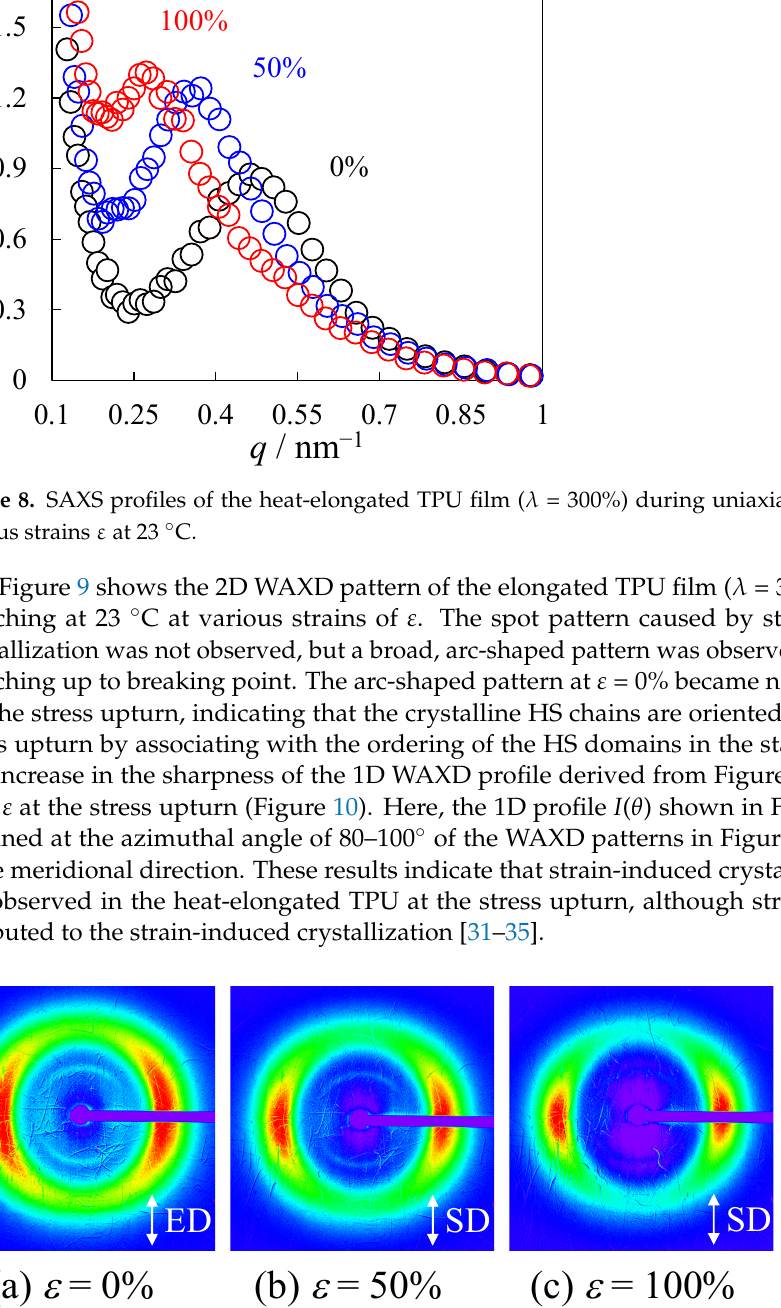
Figure 10. One-dimensional WAXD profiles of the heat-elongated TPU film ( λ = 300%) during uni- axial stretching at 23 °C at various strains ε. Thus, the stress increase at the stress upturn with λ in the elongated TPU film, as shown in Figure 1, is not attributed to the fibrillation and strain-induced crystallization, but is attributed to the increase in the densification of the HS domains tied in the stacked domain structure by the taut tie chain of the SS domains, which prevents the HS domains from fracturing during stretching due to the large energy storage that occurs during stretching to prevent the large deformation of the HS domains. This concept differs from familiar concepts regarding the strengthening at the stress upturn, which requires fibril- lation, and the strain-induced crystallization of the HS domains, but is consistent with the strengthening mechanism suggested in the heat-elongated HDPE film consisting of a stacked structure, in which the fracture of crystalline lamellae is suppressed during stretching [48]. 4. Conclusions We found that strengthening occurred without sacrificing the strain recovery by the heat elongation of the TPU film consisting of a high HS content. The stress continuously increased with elongation ratio λ , i.e., the stress at break increased from 55 to 136 MPa using the heat elongation at λ = 300%, although the stress at break of the TPU film is usu- ally below 50 MPa [11,14,23,26,41], and the literature on a high-strength TPU that can achieve a stress at break above 100 MPa is limited [29]. That is, a high-strength TPU elas- tomer could be obtained by heat elongation. The anisotropically shaped HS domains were